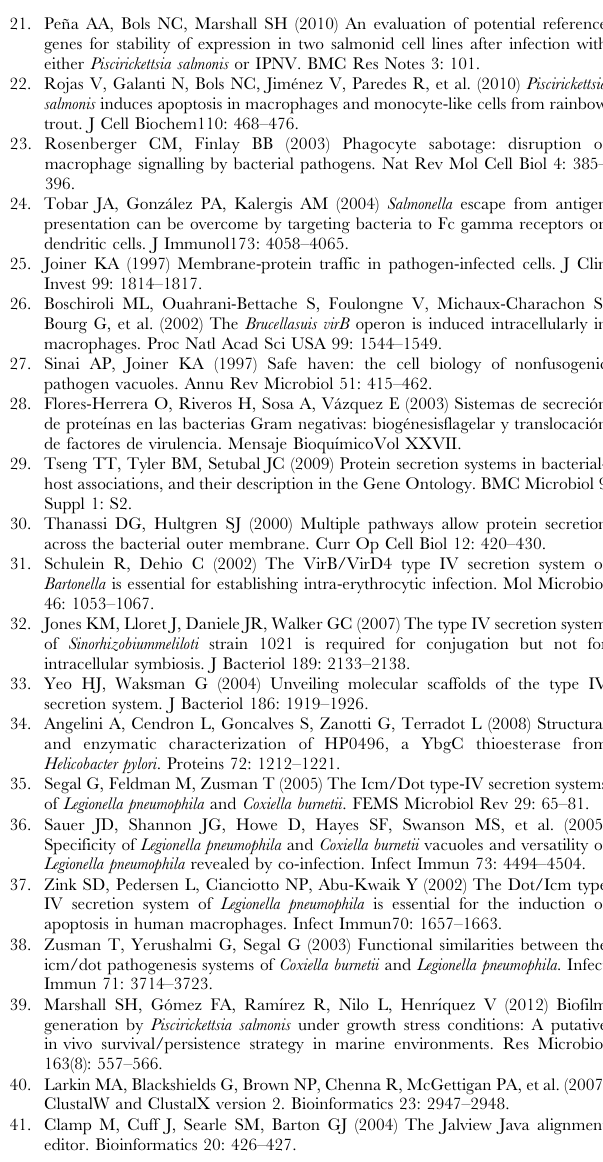
Table S1 EF1A gene Ct values of RTS11 and Sf21 cell lines during infection kinetics determined by qRT-PCR. Table S2 ITS (16 S-23 S internal transcribed spacer) Ct values obtained during P. salmonis growth kinetic at different